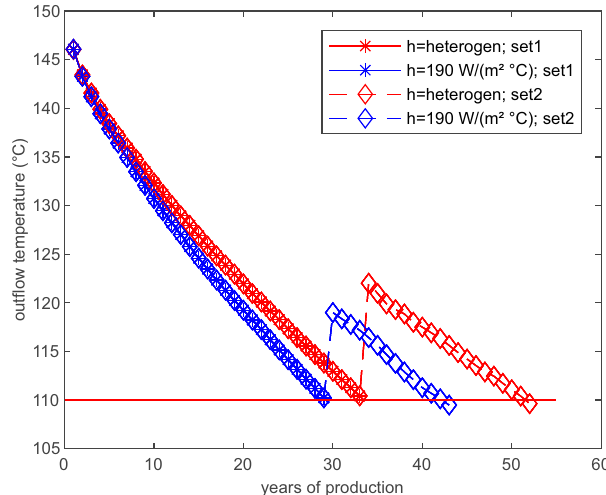
Fig.8|Switchinwellcon fi guration. Simulatedwatertemperaturesatout fl owfor a switch from well con fi guration 1 to con fi guration 2 once a threshold of 110°C is reached. The heterogeneous heat transfer simulation results in 10 years more of reservoir